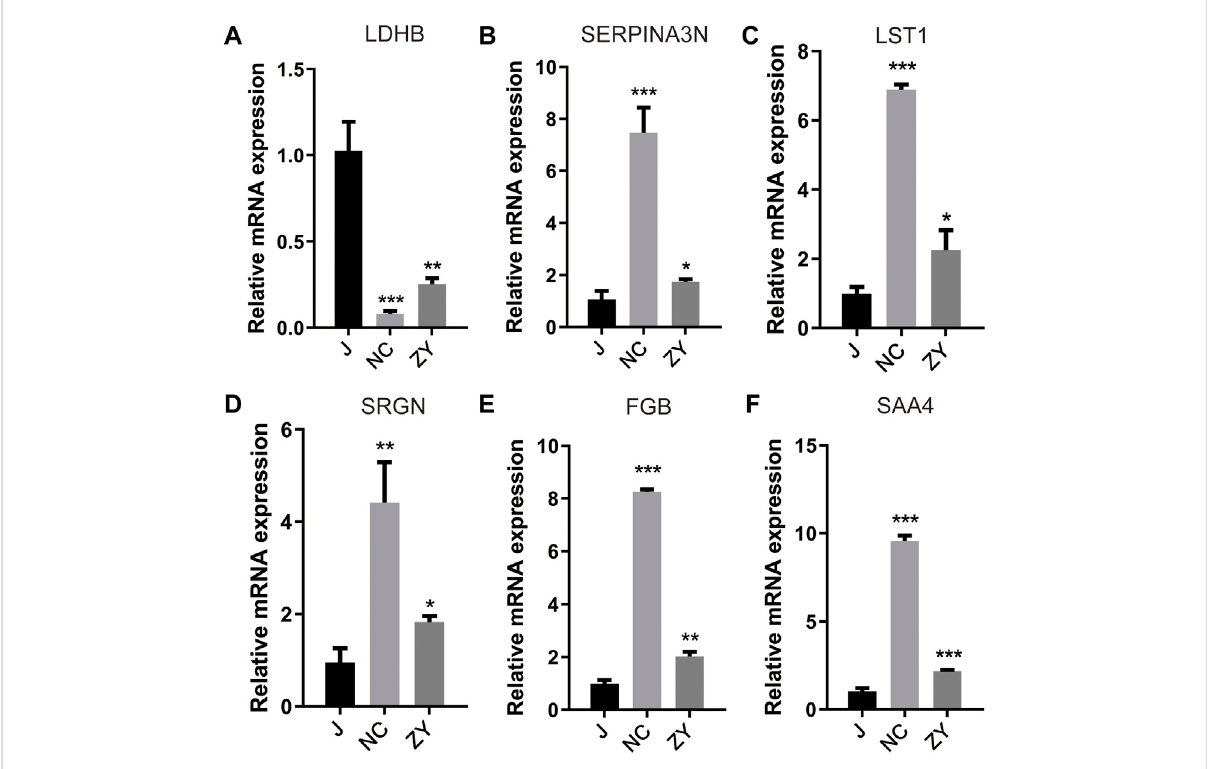
FIGURE 8 Differential expression levels for selected genes [LDHB (A) , SERPINA3N (B) , LST1 (C) , SRGN (D) , FGB (E) and SAA4 (F) ] were validated by